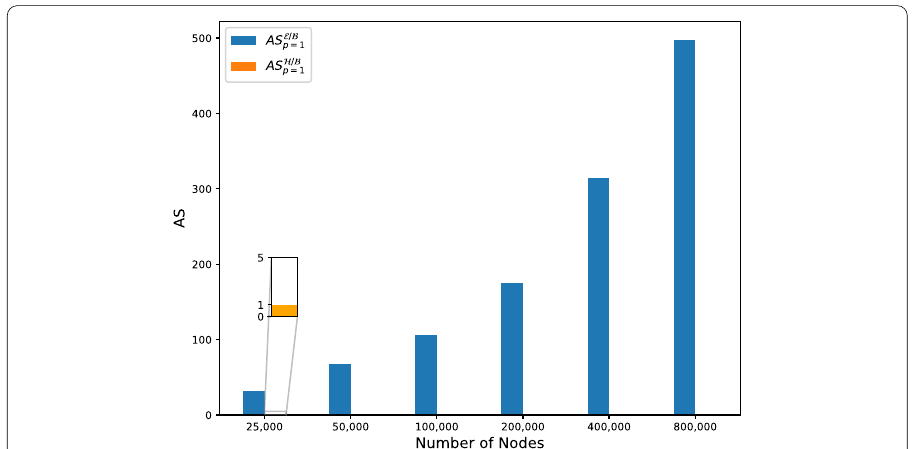
Fig. 9 Comparison with the solution proposed in [13]. Algorithmic speedup analysis with synthetic graphs in sequential mode- AS E / B p = 1 and AS H / B p = 1 . AS H / B p = 1 is always equal to 1 for synthetic graphs (see section "Synthetic graphs analysis"). We therefore add only one single zoomed bar in the figure just to make it visible to the